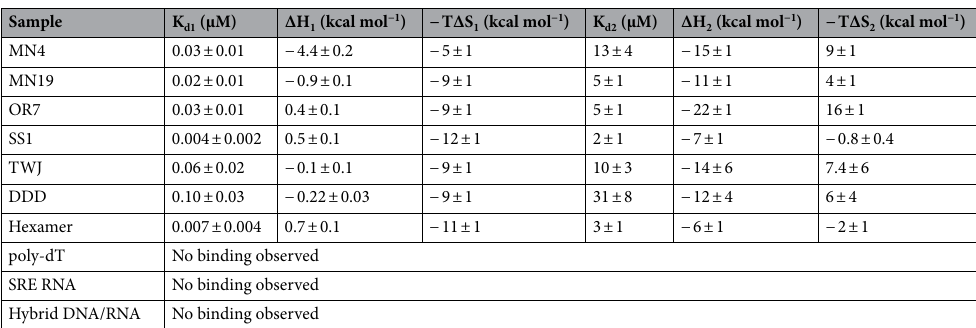
Table 1. Comparison of binding affinities and thermodynamic properties of ART binding by different nucleic acid structures used in this study. Data acquired at 15 °C in 20 mM TRIS (pH 7.4), 140 mM NaCl, 5 mM KCl, 2.4% (v/v)